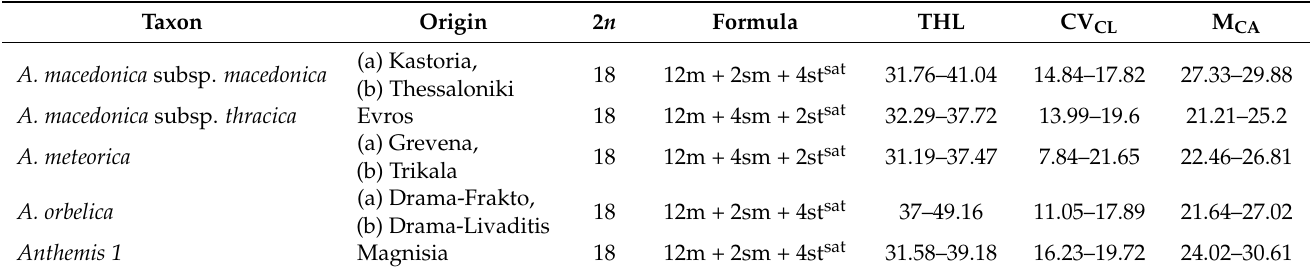
Table 2. Chromosome counts in populations of the Anthemis macedonica group, together with their karyotype formulas, total haploid length (THL) and asymmetry indices M CA and CV CL .